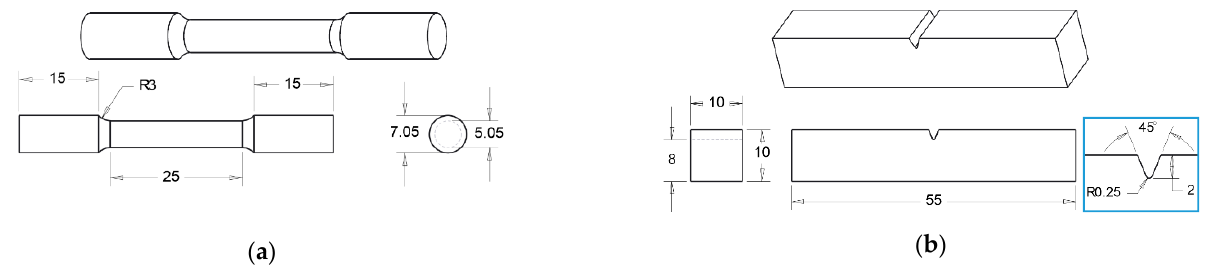
Figure 1. Standard test specimens (in mm) for ( a ) tensile and ( b ) impact experiments.